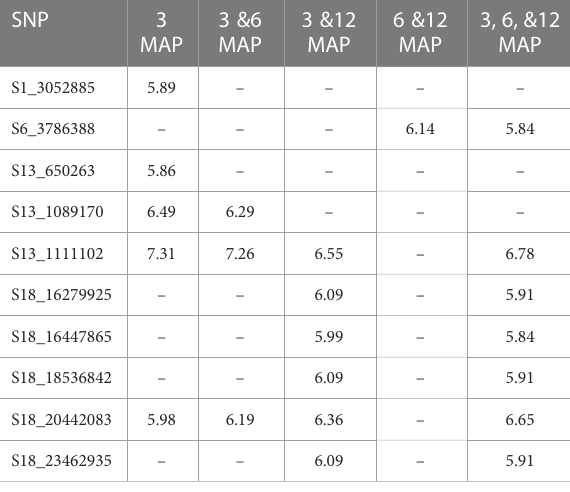
TABLE 5 Genome-wide signi fi cant markers and -log10 p-values in univariate and multivariate GWAS for CBSD severities in the C2 population. SNP